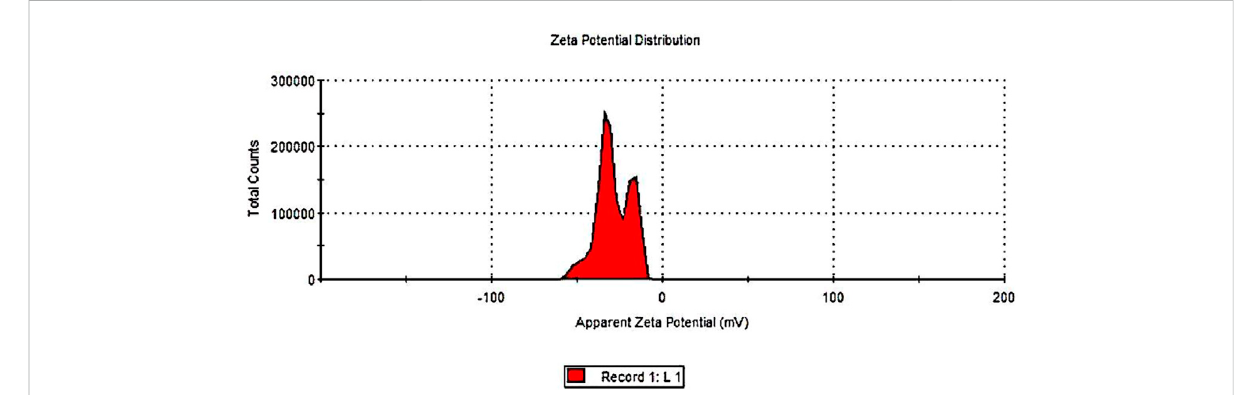
FIGURE 3 Zeta potential measurement of frankincense nanoemulsion using Malvern Zetasizer Nano